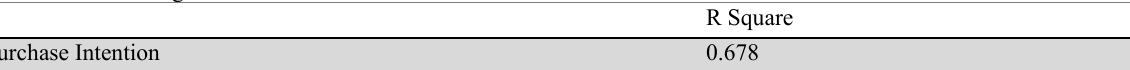
R 2 Value of the Endogenous Variable